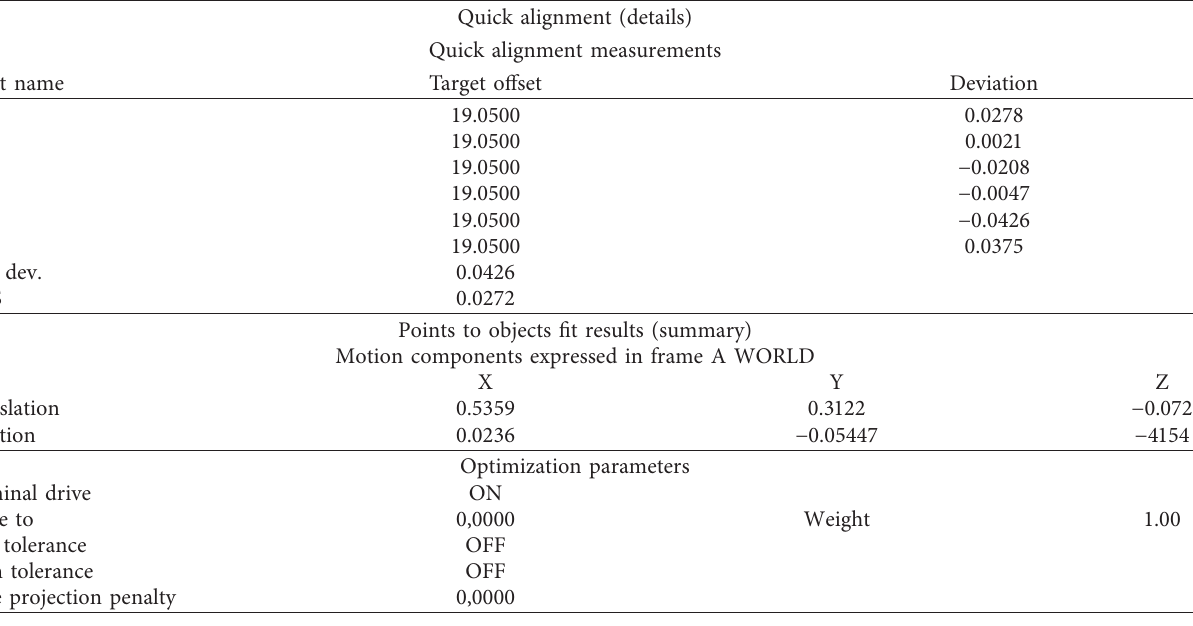
Table 5: Quick alignment and optimization parameters.